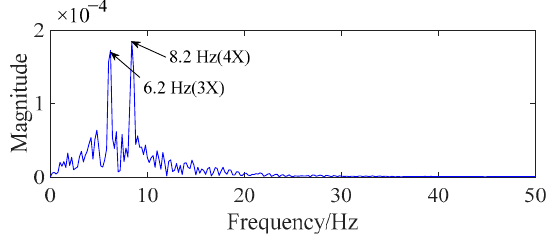
Figure 17. Gear-scuffing fault result extracted by EMD.